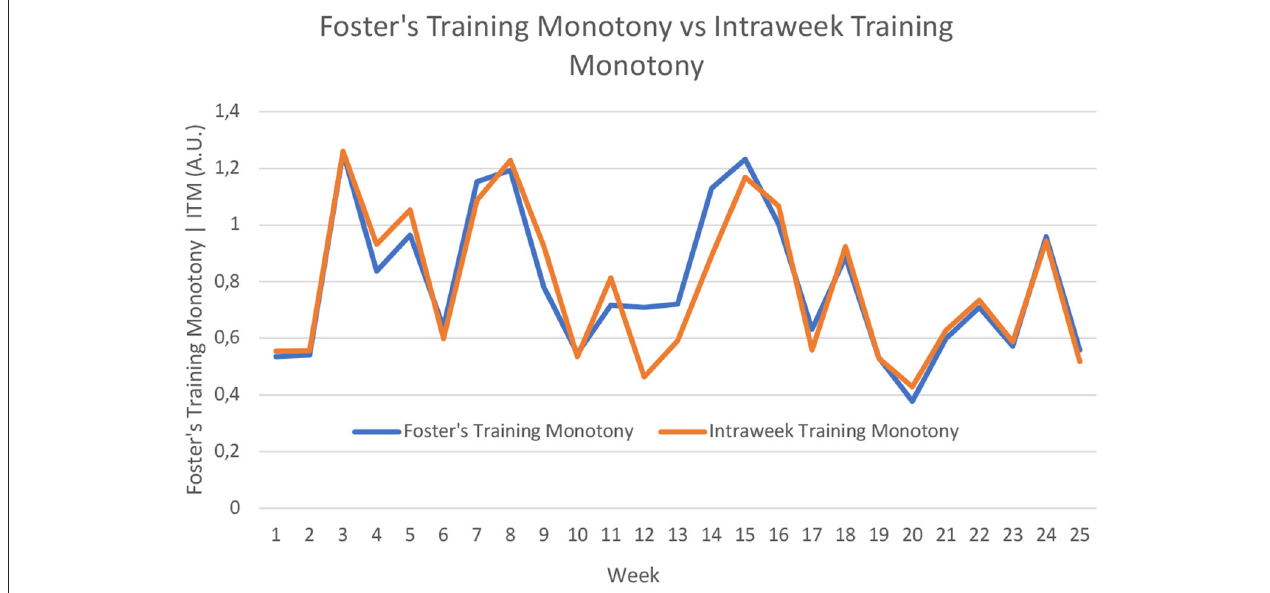
FIGURE 3 | Comparison of average data between Foster’s Monotony Index and Intraweek Monotony Index. A.U., Arbitrary units.